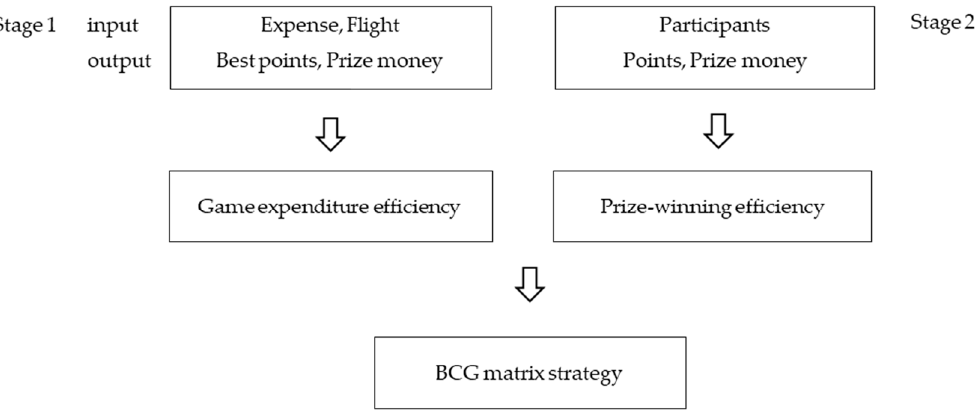
Figure 2. Conceptual framework.